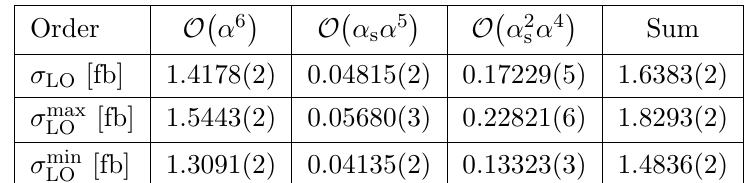
(cid:22) + (cid:23) (cid:22) e + (cid:23) e jj, stated separately for the !